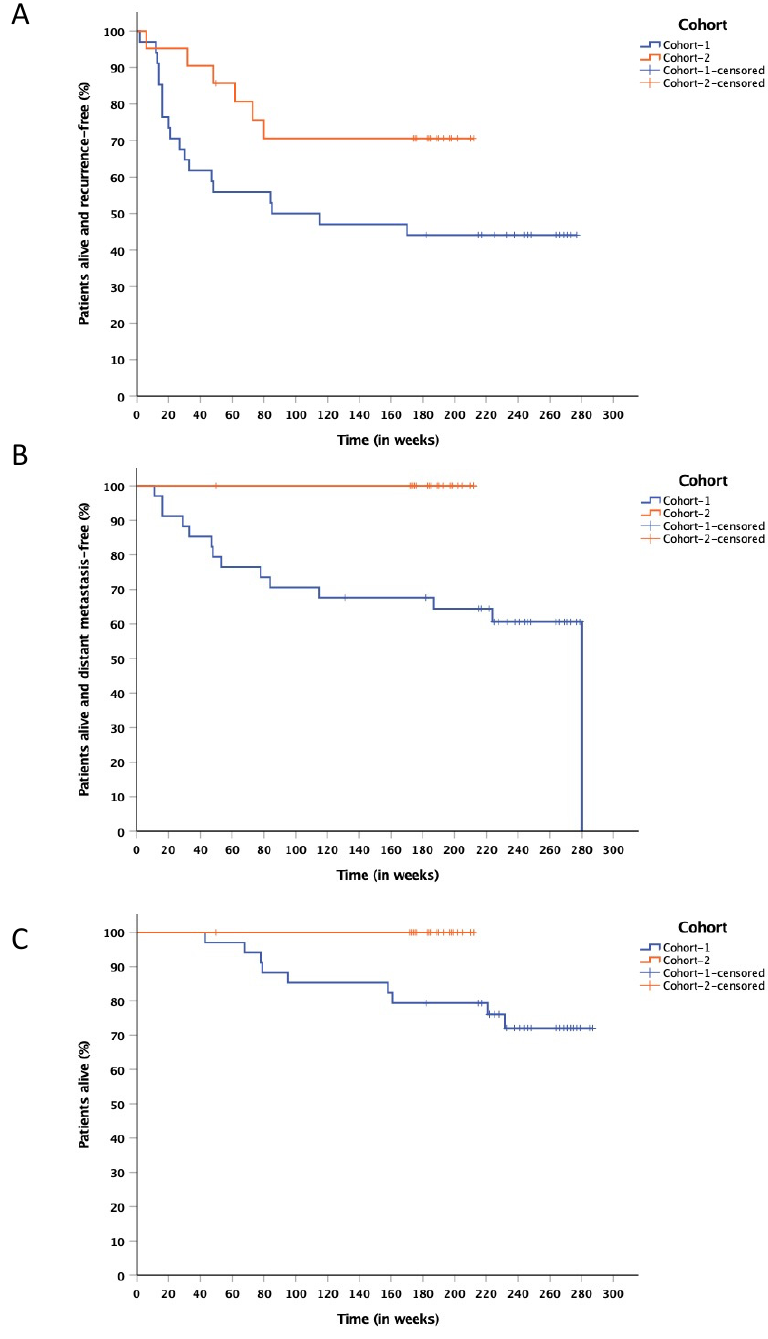
Figure 1. ( A ) Kaplan–Meier estimate of RFS in cohort-1 and cohort-2. At time of analysis, after a median follow-up of 235 (43–287) weeks for cohort-1 and 190 (50–210) weeks for cohort-2, estimated 12-months RFS-rate was, respectively, 55.9% (95% CI, 39–72) and 85.7% (95% CI, 70–100). Median RFS for cohort-1 was 85 weeks (95%, CI 0–254), not-reached in cohort-2. ( B ) Kaplan–Meier estimate of DMFS in cohort-1 and cohort-2. At time of analysis, 12-months DMFS-rate was 76.5% (95% CI, 62–90) in cohort-1. No distant metastases occurred in cohort-2. Median DMFS has not been reached at time of analysis in either cohort. ( C ) Kaplan–Meier estimate of OS in cohort-1 and cohort-2. After a median follow-up of 208 (43–256) weeks for cohort-1 and 157 (78–182) weeks for cohort-2, estimated 12-months OS-rate was, respectively, 97.1% (95% CI, 91–102) and 100%. Median OS has not been reached at time of analysis in either cohort.